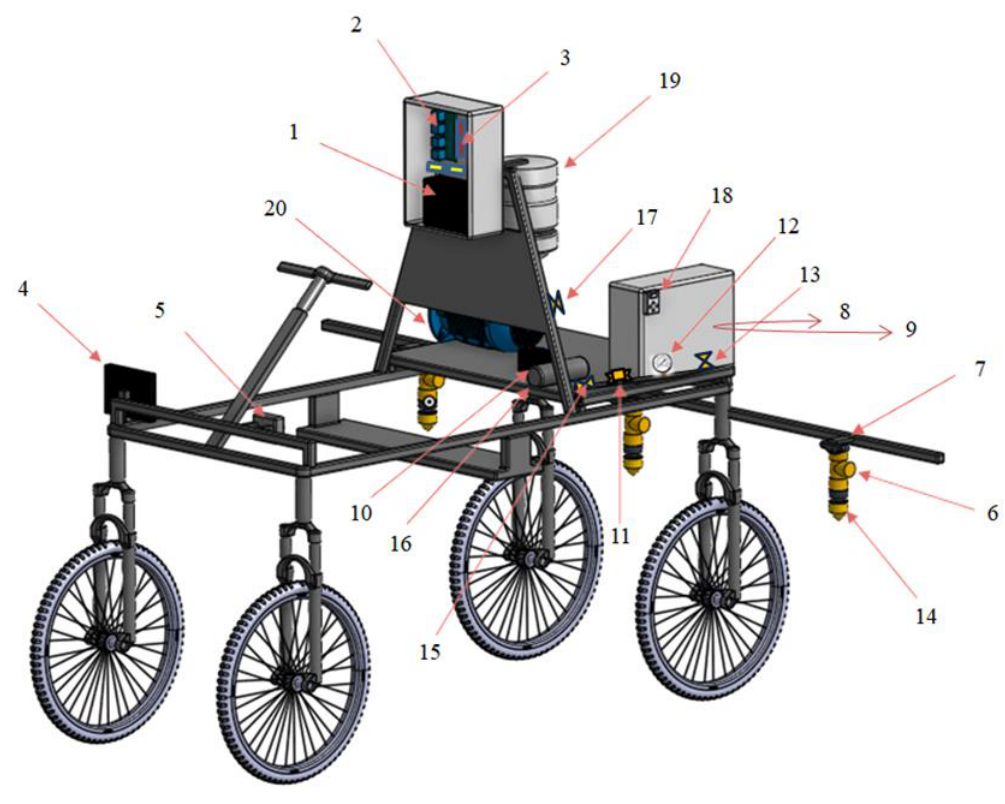
Figure 1. A model for a smart variable rate sprayer labeled for its equipment and accessories.